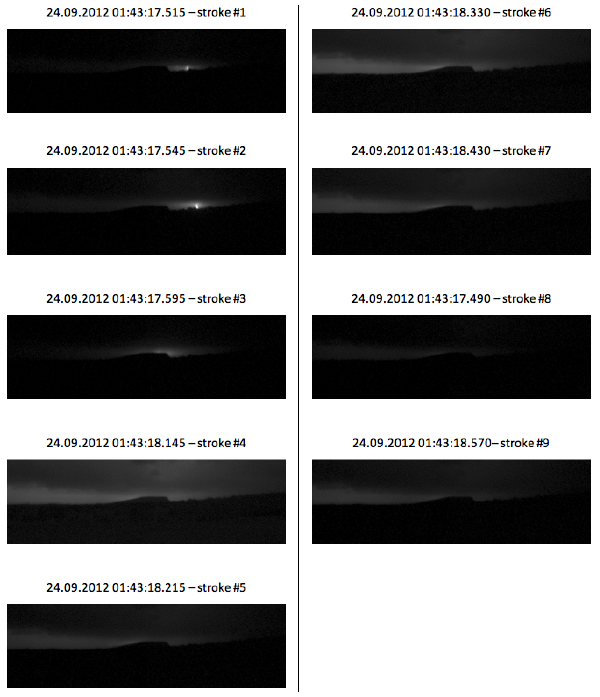
Figure 5. Enhanced VFRS 5ms frames recorded during the nine ground strokes of the − CG flash presented in Fig. 4.